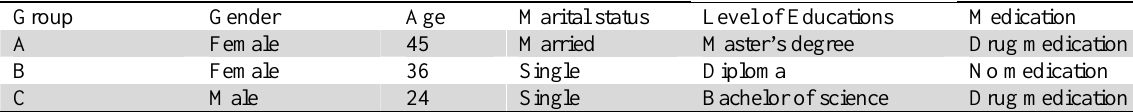
Personal characteristics of the